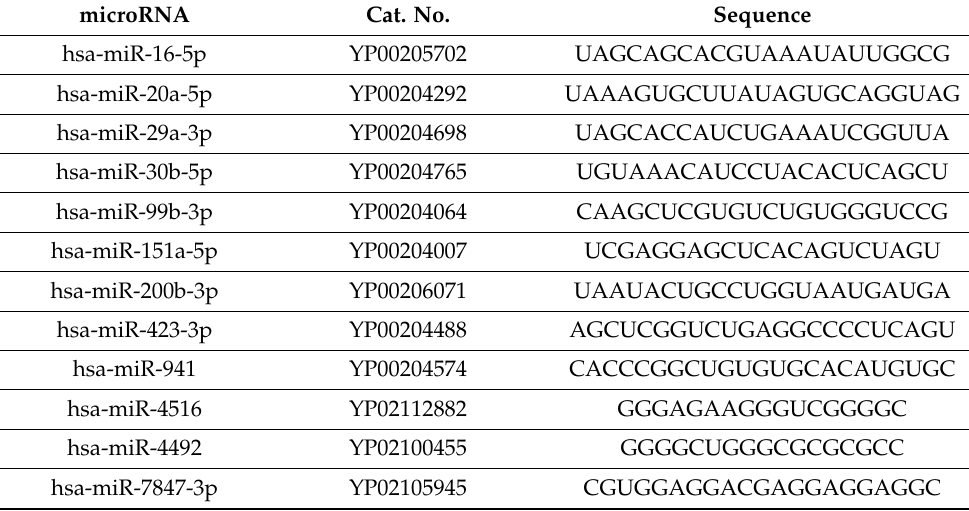
Table 1. Sequences of the microRNA primers used in this study. microRNA Cat. No. Sequence